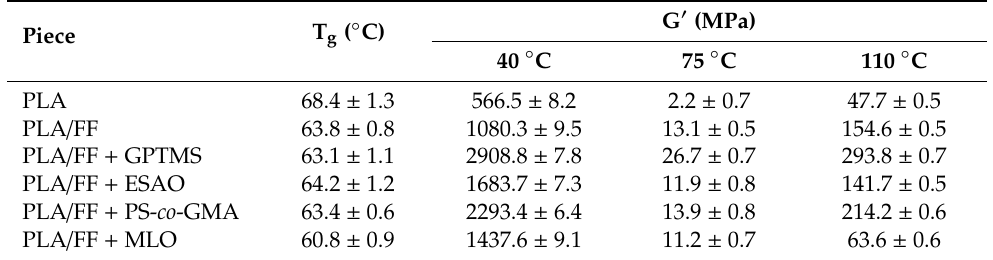
Table 5. Thermomechanical properties of the polylactide (PLA) / flaxseed fiber (FF) pieces compatibilized with (3-glycidyloxypropyl) trimethoxysilane (GPTMS), epoxy-based styrene-acrylic oligomer (ESAO), poly(styrene- co -glycidyl methacrylate) (PS- co -GMA), and maleinized linseed oil (MLO) in term of: storage modulus (G (cid:48) ) measured at 40 ◦ C, 75 ◦ C, and 110 ◦ C and glass transition temperature ( T g ). ◦ Piece T g (